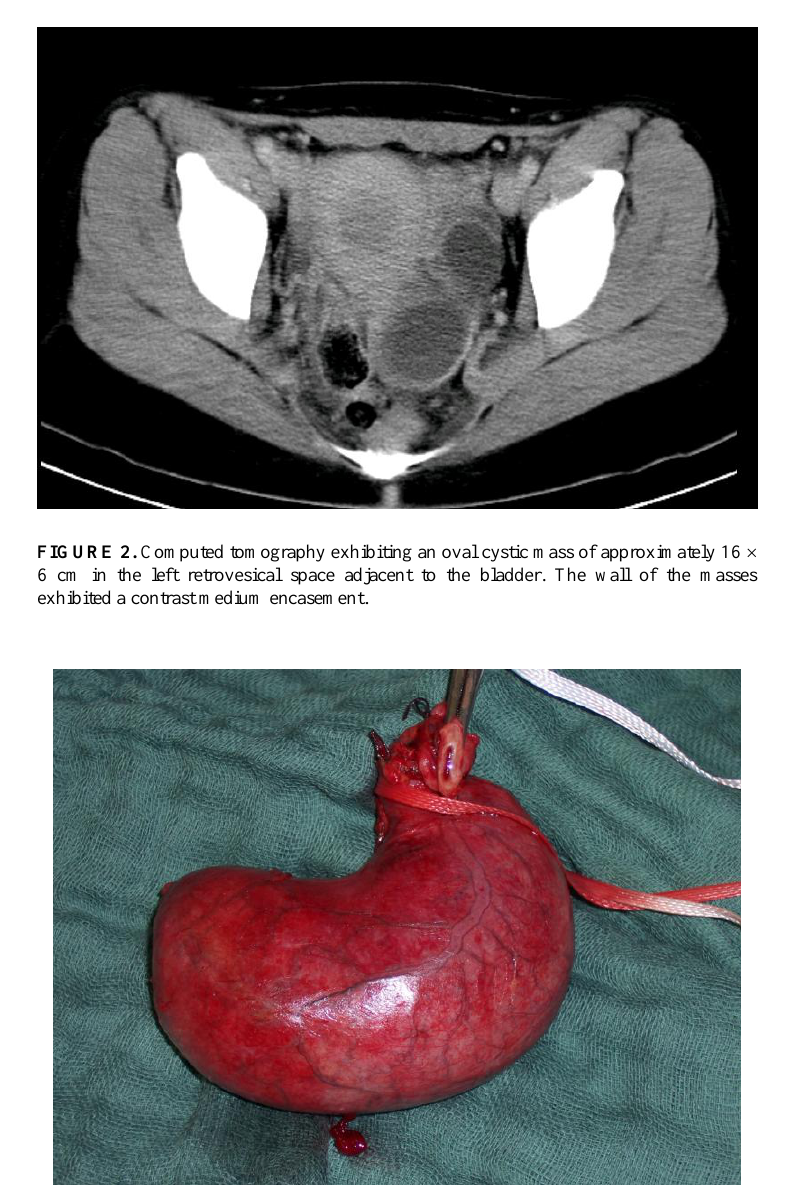
FIGURE 3. The pathologic specimen dissected in